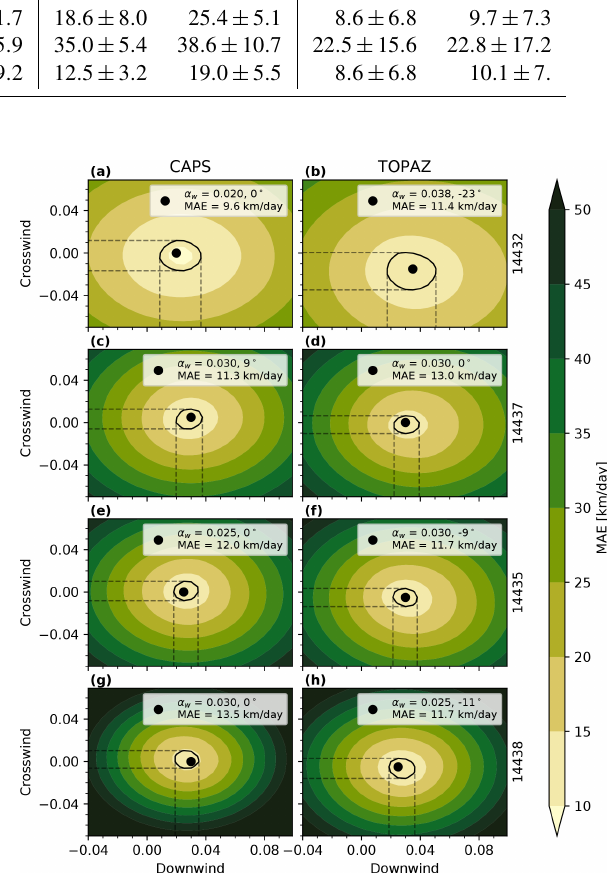
Figure 5. Filled contours of MAE (in kmd − 1 ) between observed drift velocities and Eq. (3) for the along- and cross-wind compo- nents of α w with α i = 0 . 02 e − iπ/ 6 . The left column uses CAPS forcing, and the right column uses TOPAZ forcing. The black dot shows the location of the MAE minimum, and the black contour line shows the MAE value within 1kmd − 1 of the minimum. Each row is for an individual drifter in order from high ice concentration at the top to low ice concentration at the bottom. Sensitivity to choice of α w is opposite to that of α i in Fig. 4 with less sensitivity in high ice concentration relative to